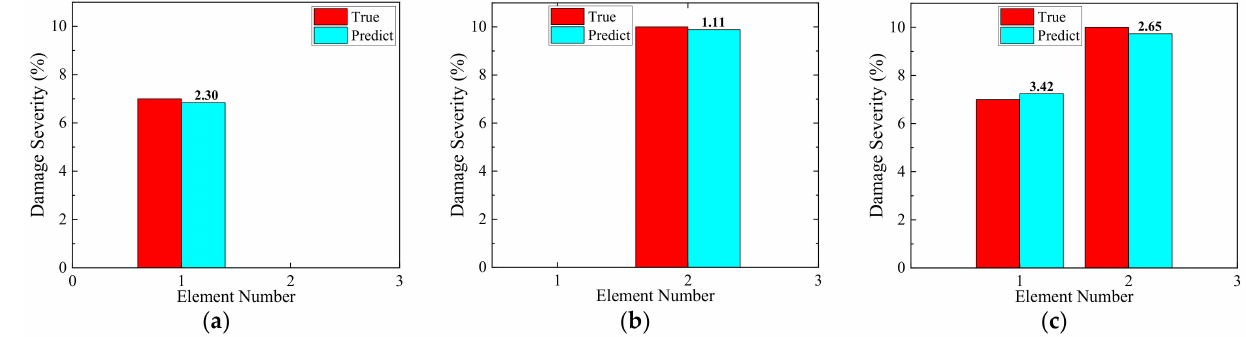
Figure 13. Damage identification results and corresponding errors for the three-storey frame. ( a ) State 1; ( b ) State 2; and ( c ) State